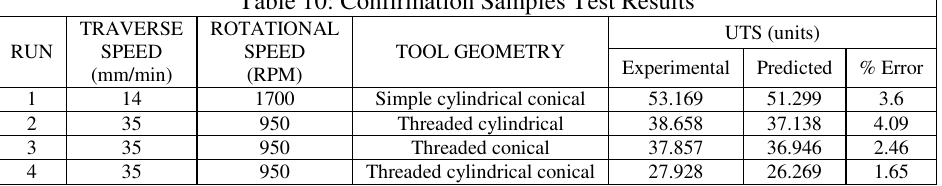
Table 10: Confirmation Samples Test